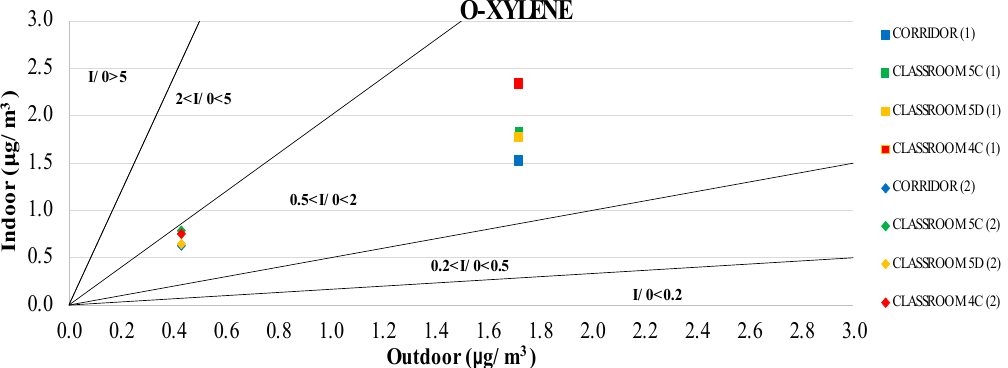
Figure 4. M, P, Xylenes indoor concentrations against outdoor concentrations in all monitored sites during the first (1) and the second (2) monitoring periods.